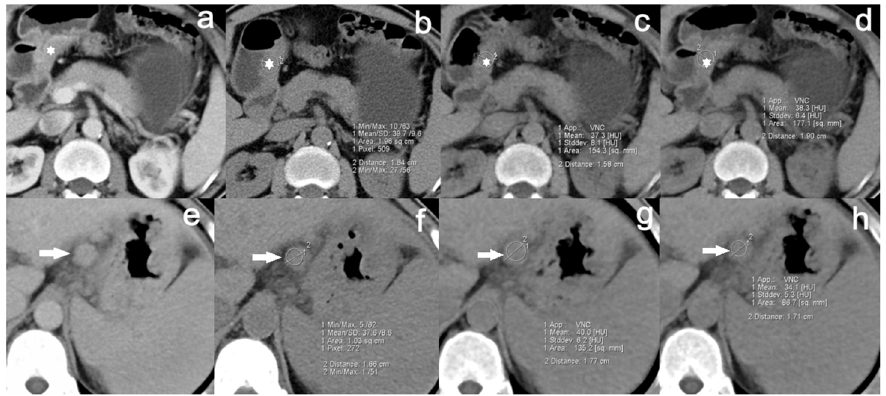
Figure 4. VNE images were acceptable for diagnosis purpose. a , d A 56-year-old man with advanced gastric cancer in the lesser curvature of the antrum. a Transverse CT scans show focal wall thickening (asterisk) of the lesser curvature of the gastric antrum with abnormal enhancement. VNE A image ( c ), VNE P image ( d ) and TNE image ( b ) show good correlation of measured CT numbers and thickness of the tumor (TNE: 39.7 HU 6 9.6, 1.84 cm; VNE A : 37.3 HU 6 8.1, 1.58 cm; VNE P : 38.3 HU 6 6.4, 1.90 cm). e , h A 62-year-old man with advanced gastric cancer in the fundus. e Transverse CT scans show an enlarged lymph node (arrow) in the lesser curvature of the gastric body. VNE A image ( g ), VNE P image ( h ) and TNE image ( f ) show good correlation of measured CT numbers and diameter of the node (TNE: 37.6 HU 6 8.6, 1.66 cm; VNE A : 40.0 HU 6 6.2, 1.77 cm; VNE P : 34.1 HU 6 5.3, 1.71 cm). Both of the patients are noted excellent VNE image quality. doi:10.1371/journal.pone.0112295.g004 71/74) VNE P images were regarded as having the potential to replace TNE images by two experienced abdominal radiologists (Table 2). Overshooting artifact detected at the gas-fluid level was more obvious in VNE images than TNE images in 3 cases (Fig. 5).